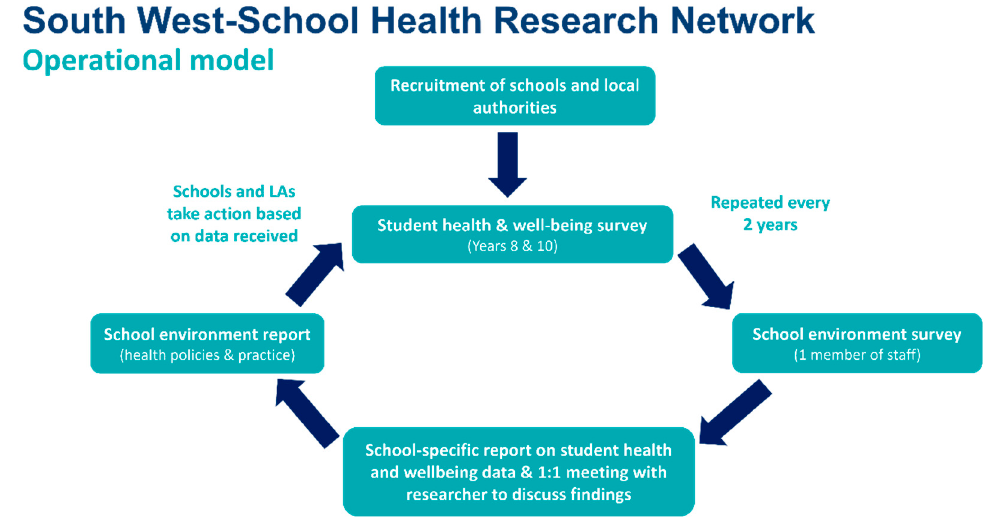
Figure 1. SW-SHRN Operational Model .